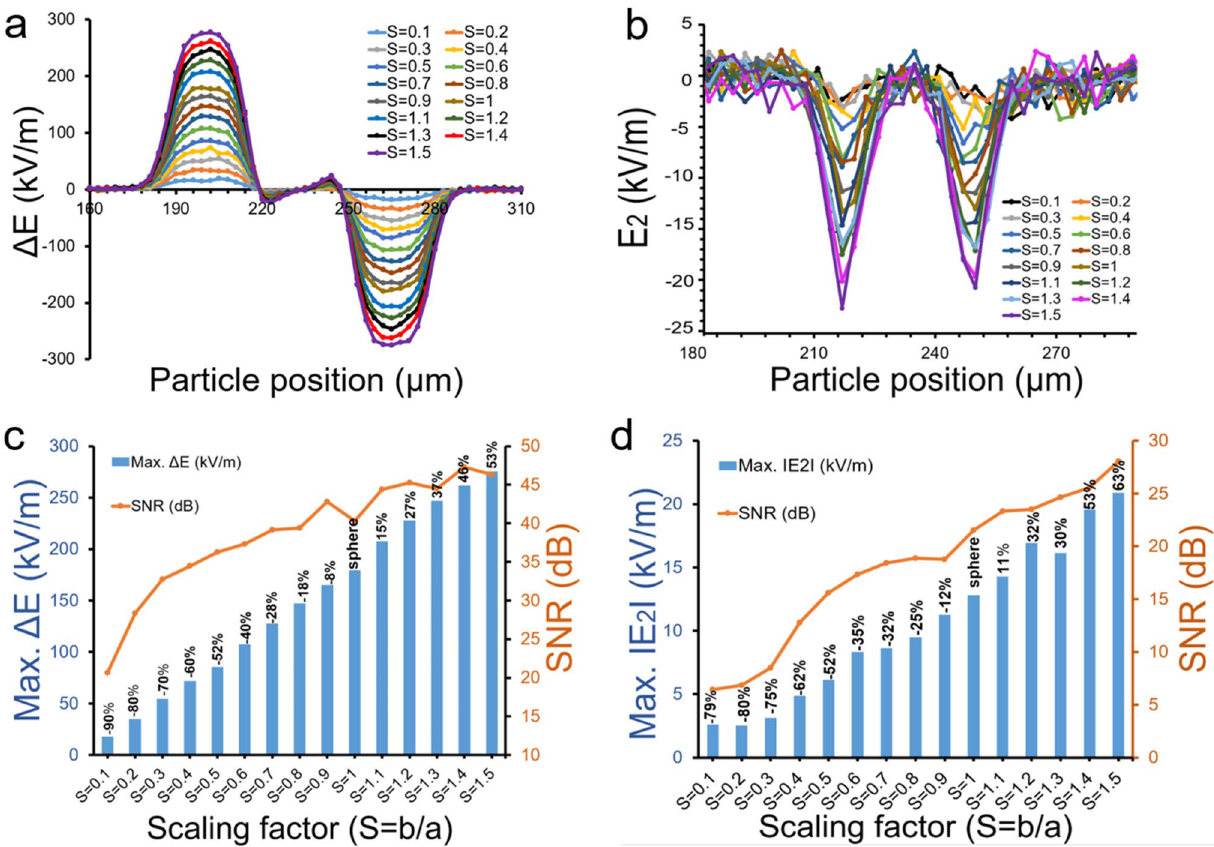
Figure 4. IE-1: Gradual change from spherical to non-spherical shape bioparticle i.e. S = 0.1–1.5 (with a = 5 µm remains fixed) for IE-1 design. ( a , b ) Simulation of ΔE and │ E 2 │ signals for particle axis ratio, S = b/a from 0.1 to 1.5. ( c , d ) Comparison of maximum values of ΔE and │ E 2 │ and their respective SNR in dB for particle shape ratio, S from 0.1 to 1.5. Plots ( a – d ) are drawn in Microsoft Excel